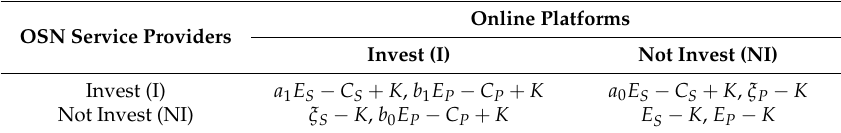
Table 4. Payoff Matrix under an incentive